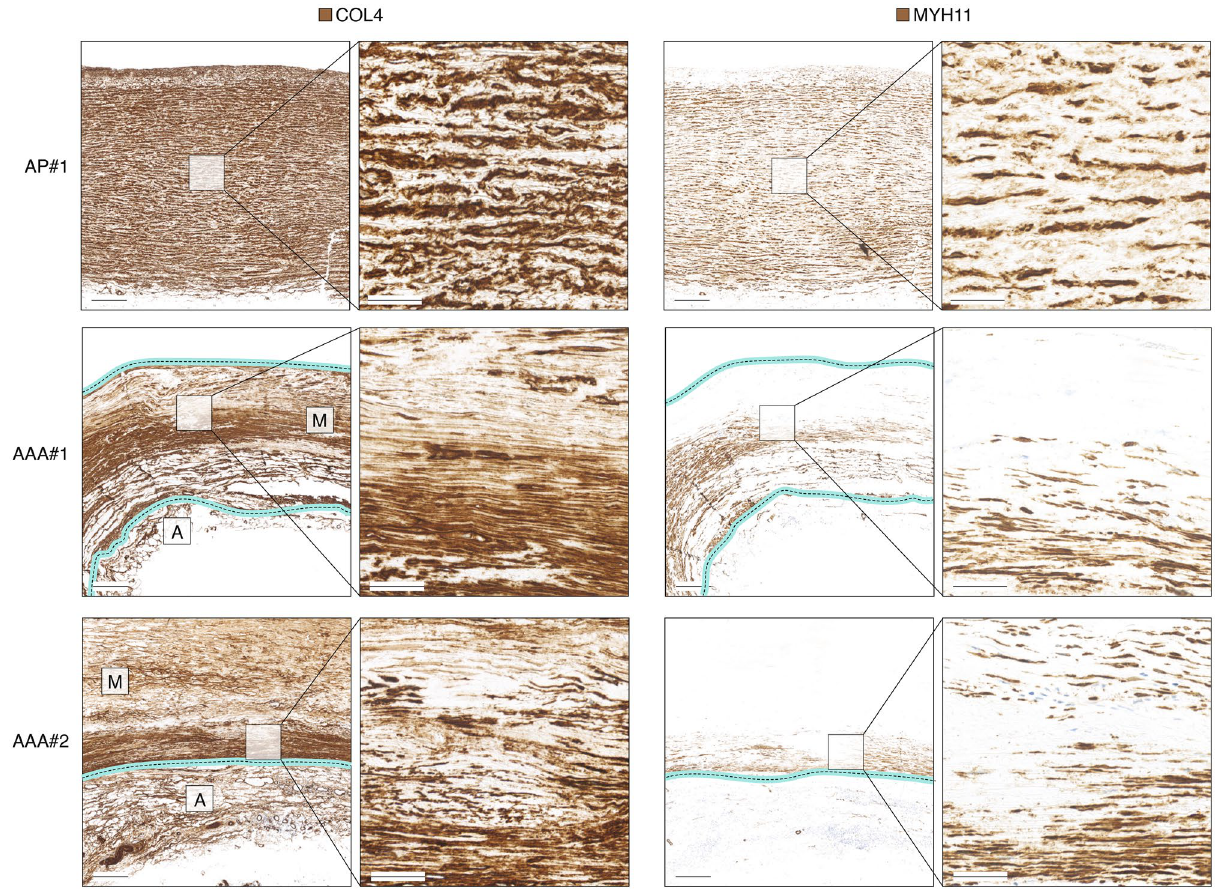
Figure 4. COL4 and MYH11 immunohistochemical staining of non-lesioned ascending aorta and two examples of AAA lesions. To assist assessment of AAA lesions, the partially degraded medial (M) and adventitial (A) layers are labeled on overview images of COL4 stainings, and the media borders are marked with cyan/dotted lines. Images are representative specimens of 5 aortic punch- and 5 AAA-samples analyzed, and images of remaining specimens are shown in Supplementary Fig. 5. Scalebars (overview) = 1 mm; Scalebars (magnification) = 200 µm. AP = Aortic punch (ascending thoracic aorta). #1–#2 refer to sample IDs.